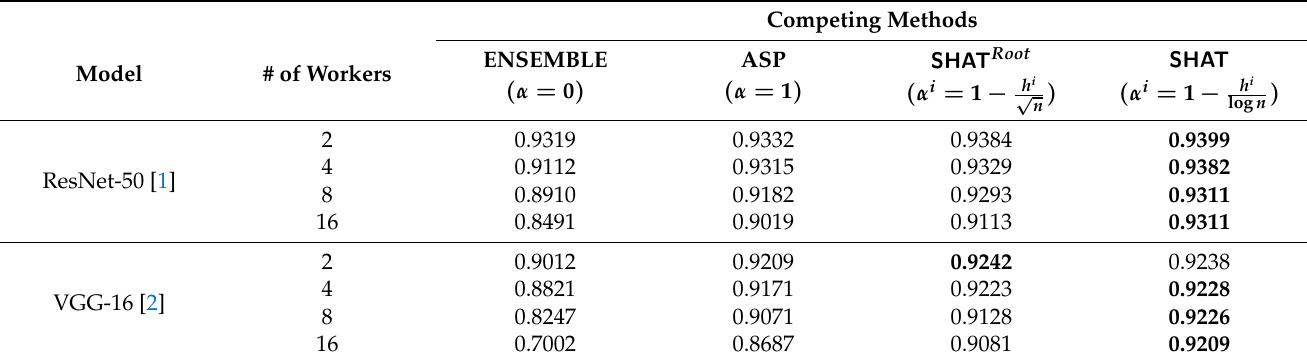
Table 2. The model accuracy of asynchronous training with different update methods. Competing